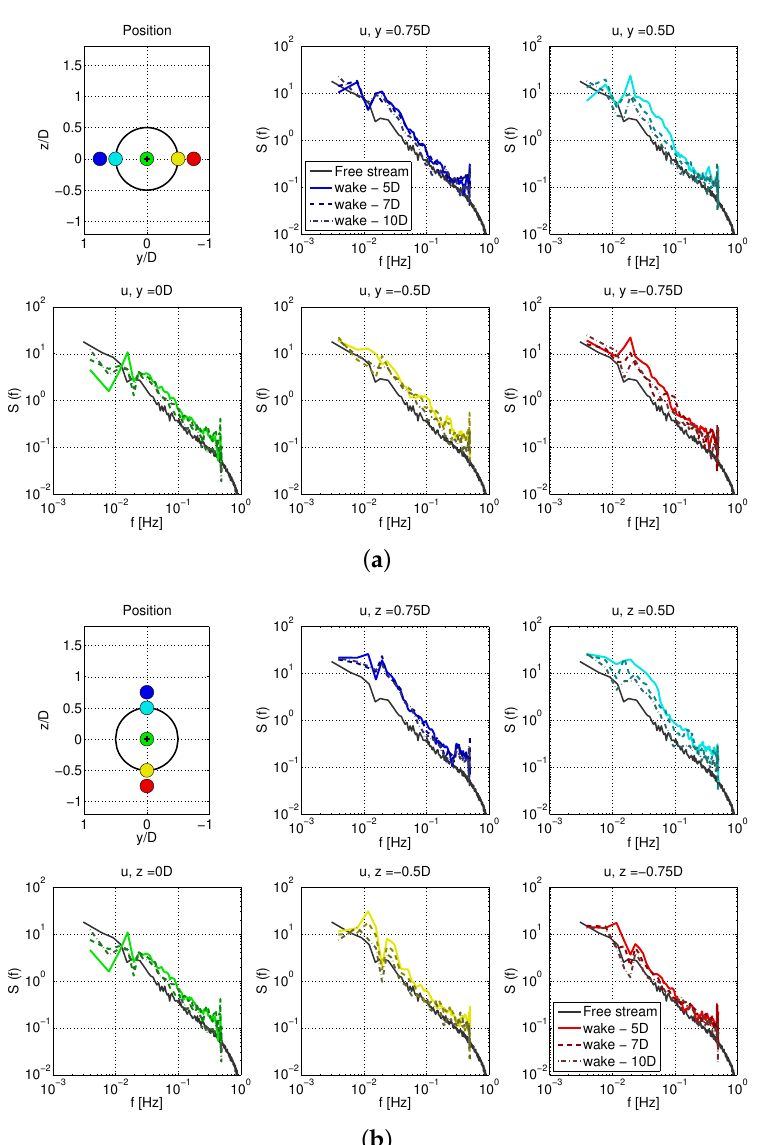
Figure 11. Power spectral density functions of u at x = 0, 5 D , 7 D , and 10 D : ( a ) lateral variation; and ( b ) vertical